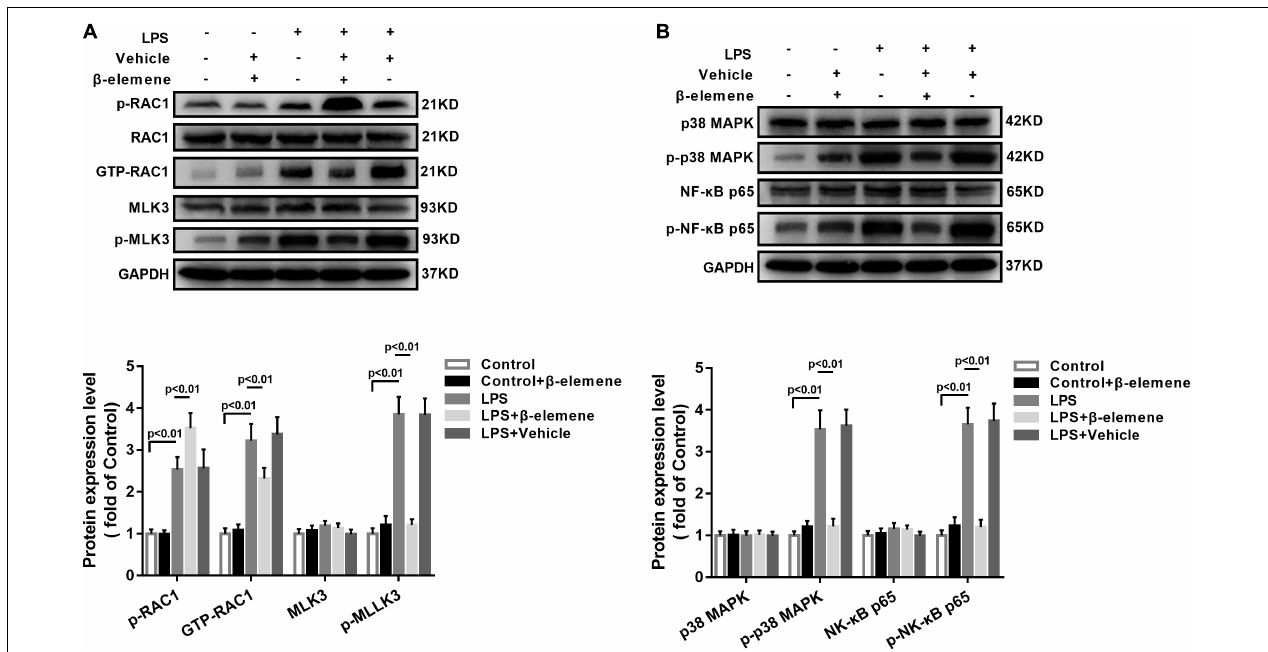
FIGURE 2 | β -Elemene enhanced phosphorylation of RAC1 and weakened activation of RAC1, MLK3, and p38 in BV-2 cells. (A) β -Elemene enhanced RAC1 phosphorylation [F(4, 15) = 42.7] and weakened GTP-RAC1 production [F(4, 15) = 40.61] and MLK3 phosphorylation [F(4, 15) = 79.78]. Phosphorylation of RAC1 was normalized to that of RAC1. Other protein expressions were normalized to that of GAPDH. (B) β -Elemene significantly reduced the phosphorylation of p38 [F(4, 15) = 63.23] and p65 [F(4, 15) = 69.23] normalized to that of GAPDH. n = 4. Two-way ANOVA revealed a significant difference at p <